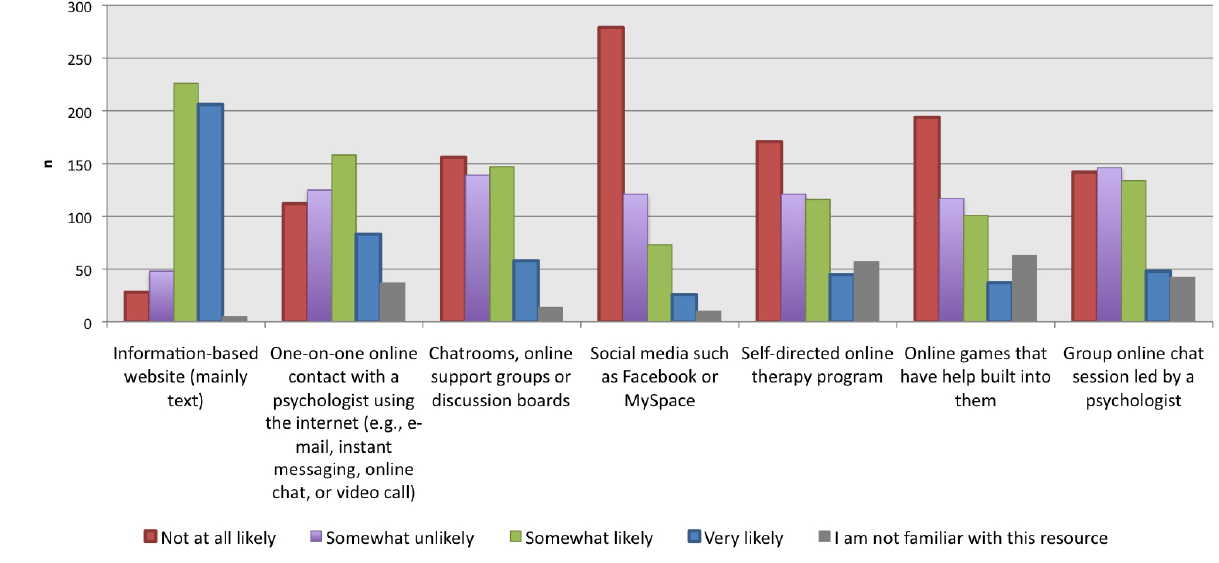
Figure 1. Likelihood of visiting Web-based resources during a difficult time in